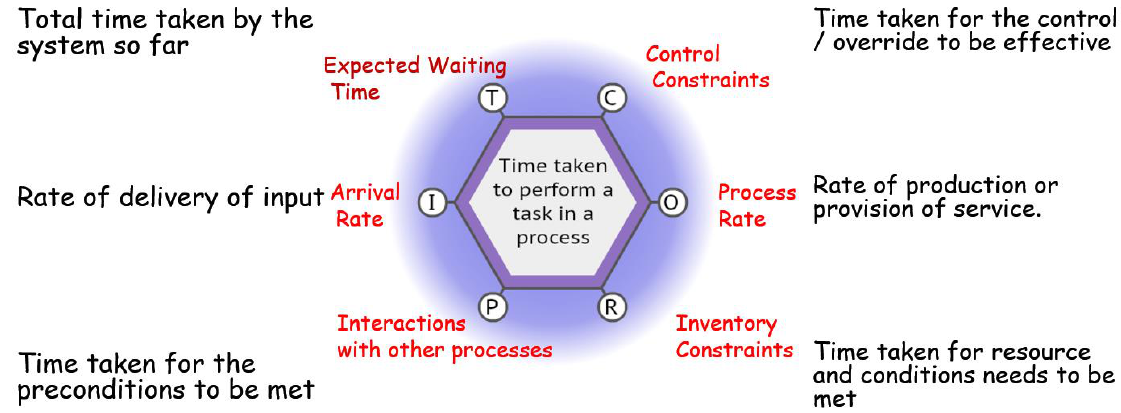
Figure 2. The additional temporal aspects of interest for a typical FRAM function.